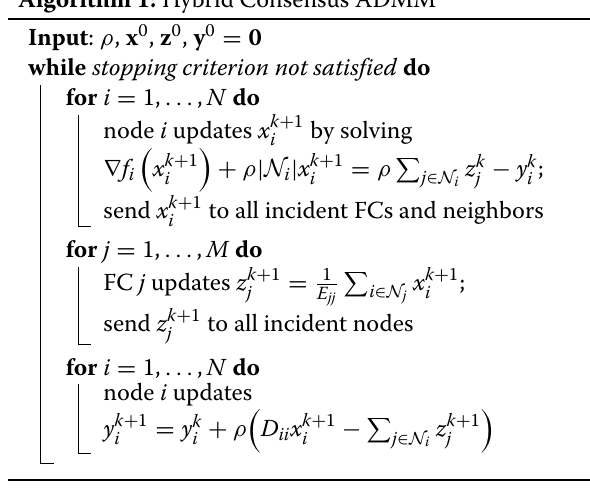
Algorithm 1: Hybrid Consensus